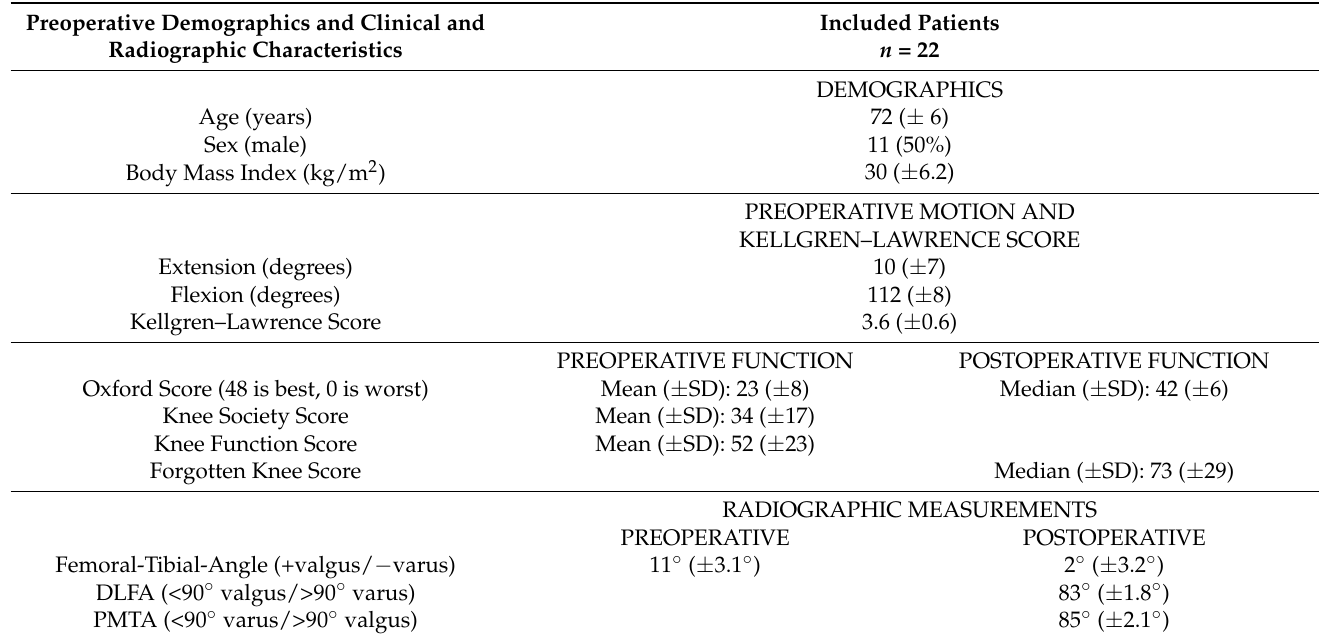
Table 1. Preoperative Patient Demographics, Clinical and Radiographic Characteristics, and Pre-and Postoperative Function of Included